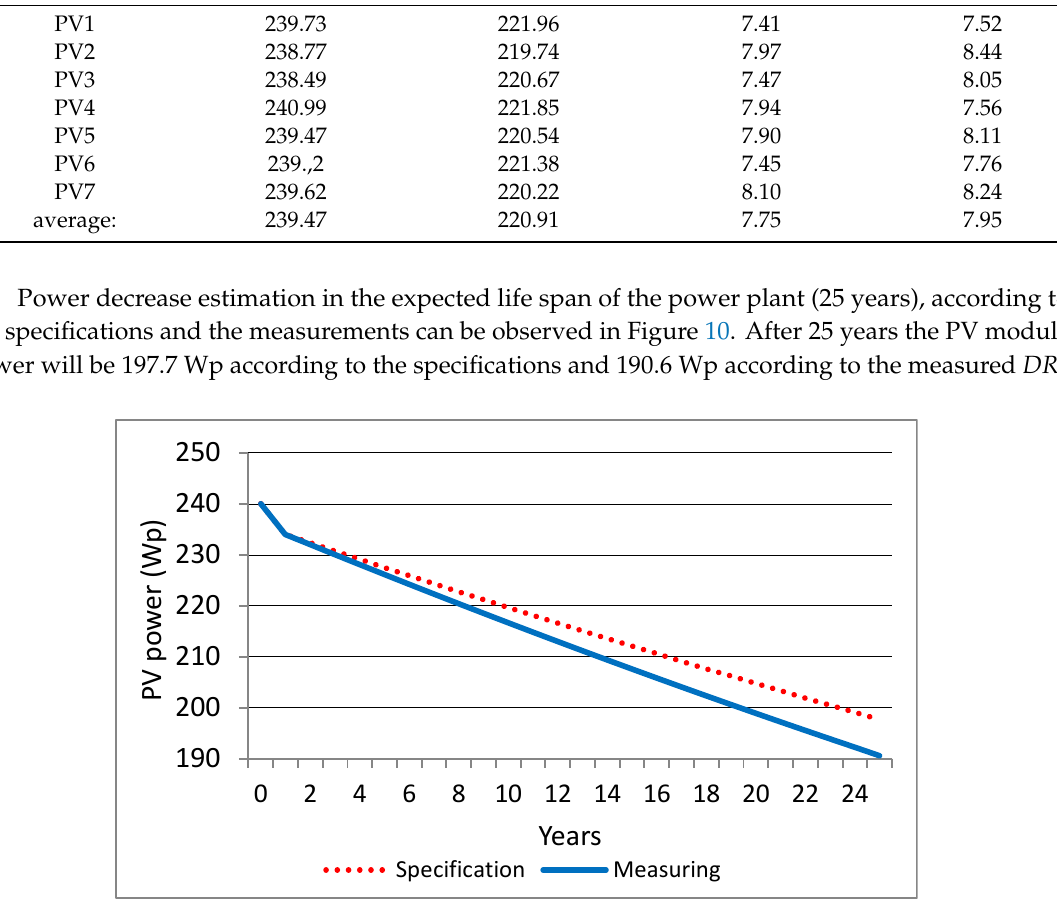
Figure 10. Power decrease estimation during 25 years.